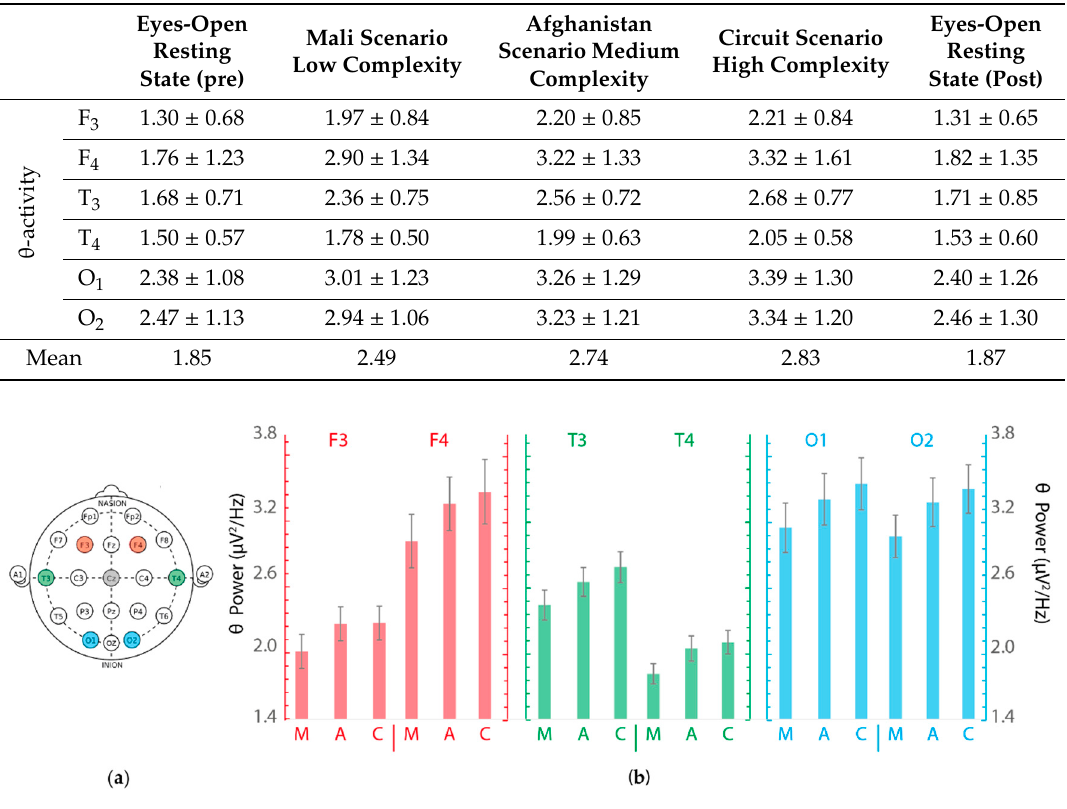
Table 2. Comparison of the means ± standard deviations of the EEG theta power spectrum ( θ -activity) per channel ( µ V2 / Hz), for the baseline measurements (eyes-open resting state measurements before (pre) and after (post) the simulation) and the three simulated mission scenarios ( n = 35). The last row shows the mean θ -activity across all six channels for each measurement / scenario. Eyes-Open State (pre)